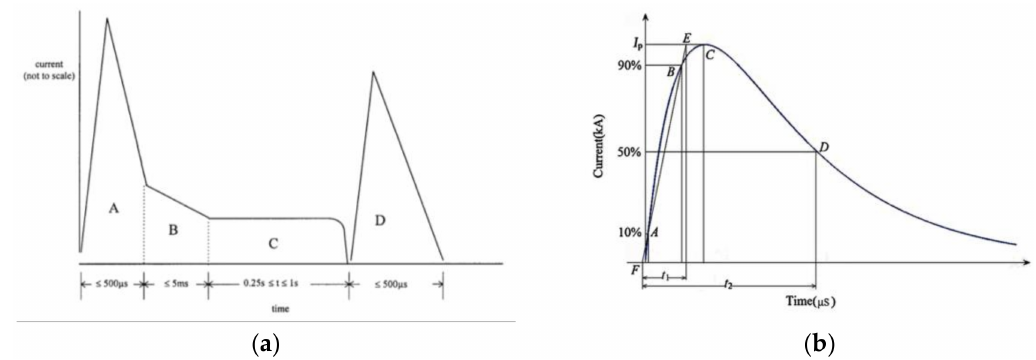
Figure 4. Typical lightning current waveforms: ( a ) 4 types of lightning current waveforms; ( b ) meanings of di ff erent symbols in Table